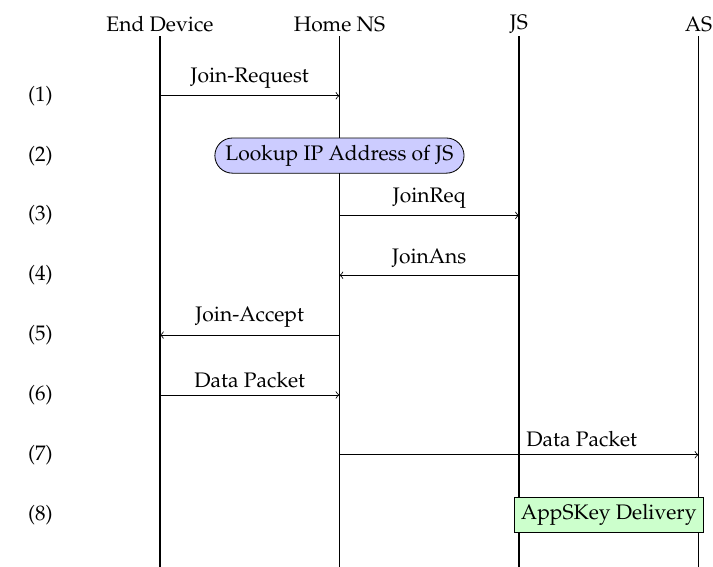
Figure 3. Flow chart of operations for joining the home network. JS and AS denote the join server and the application server,